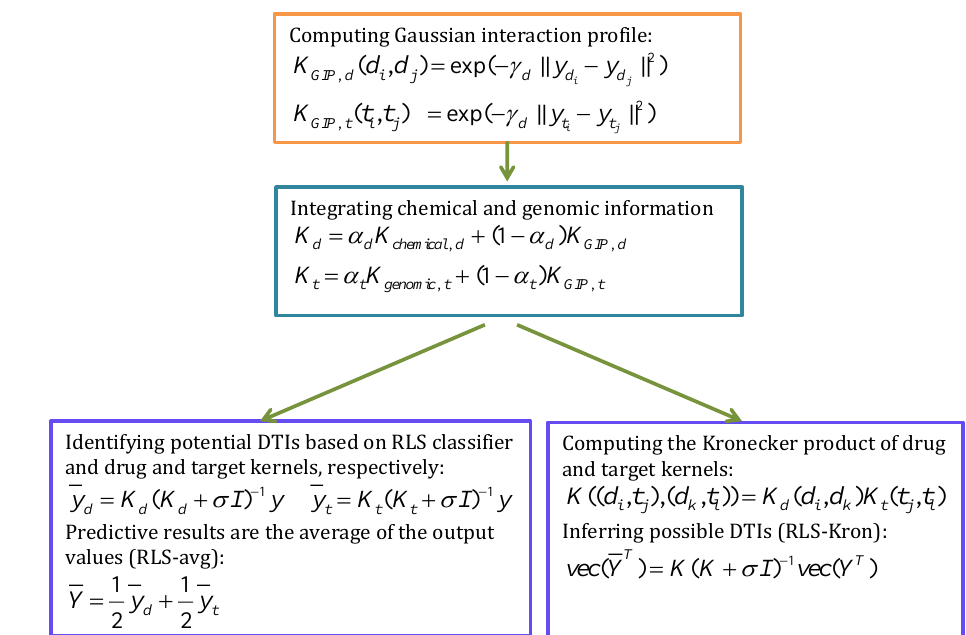
Figure 8. The flowchart of regularized least squares (RLS) GIP